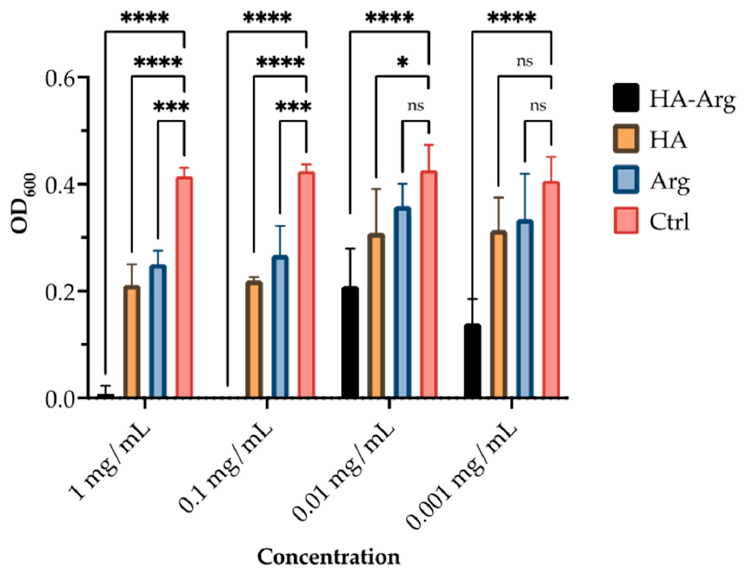
Figure 8. Antimicrobial activity of HA, Arg, and HA–Arg, against P. acnes . Bacterial growth was quantified by OD 600 using a spectrophotometer. Data are the mean of 3 independent experiments performed in triplicate (mean +/ − SD); ns p ≥ 0.1; * p < 0.1; ** p < 0.01; *** p < 0.001; **** p ≤ 0.0001 (TWO WAY ANOVA followed by Dunnett post test)